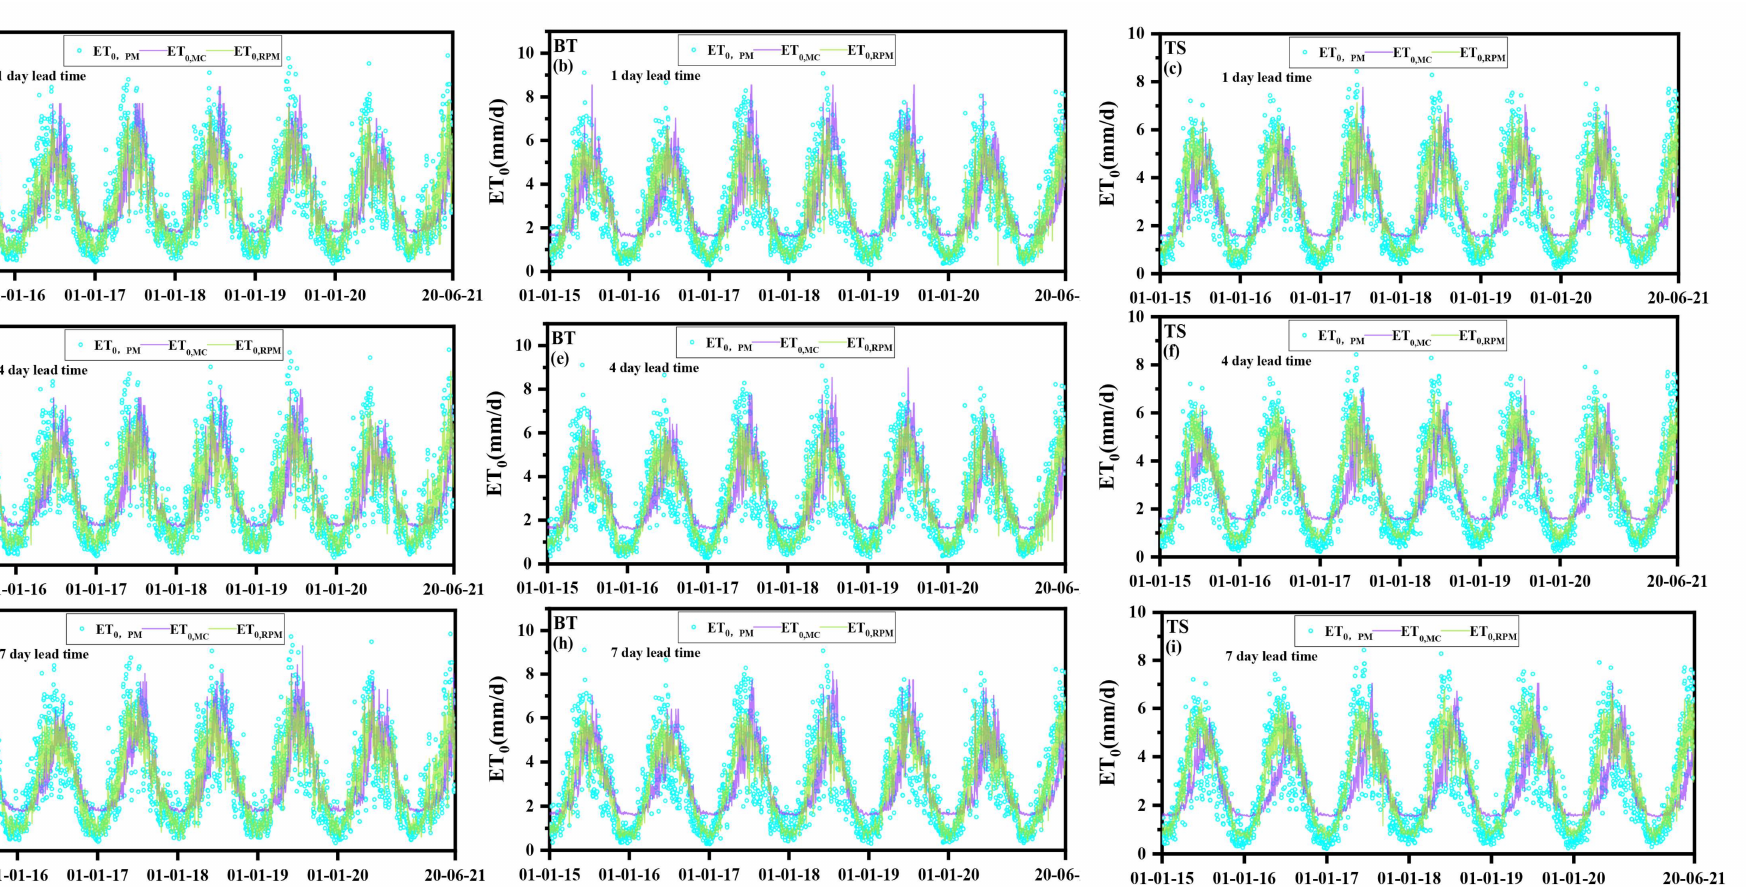
Figure 6. Comparisons of ET 0 forecasts between MC and RPM temperature-based models and PM for BT, TS, and XX; ( a – c ) 1 d ahead, ( d – f ) 4 d ahead, and ( g – i ) 7 d